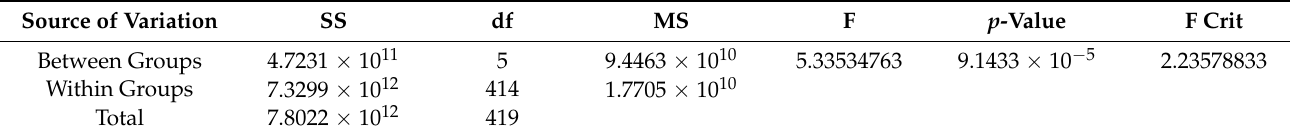
Table 2. Statistical analysis of experimental DGA